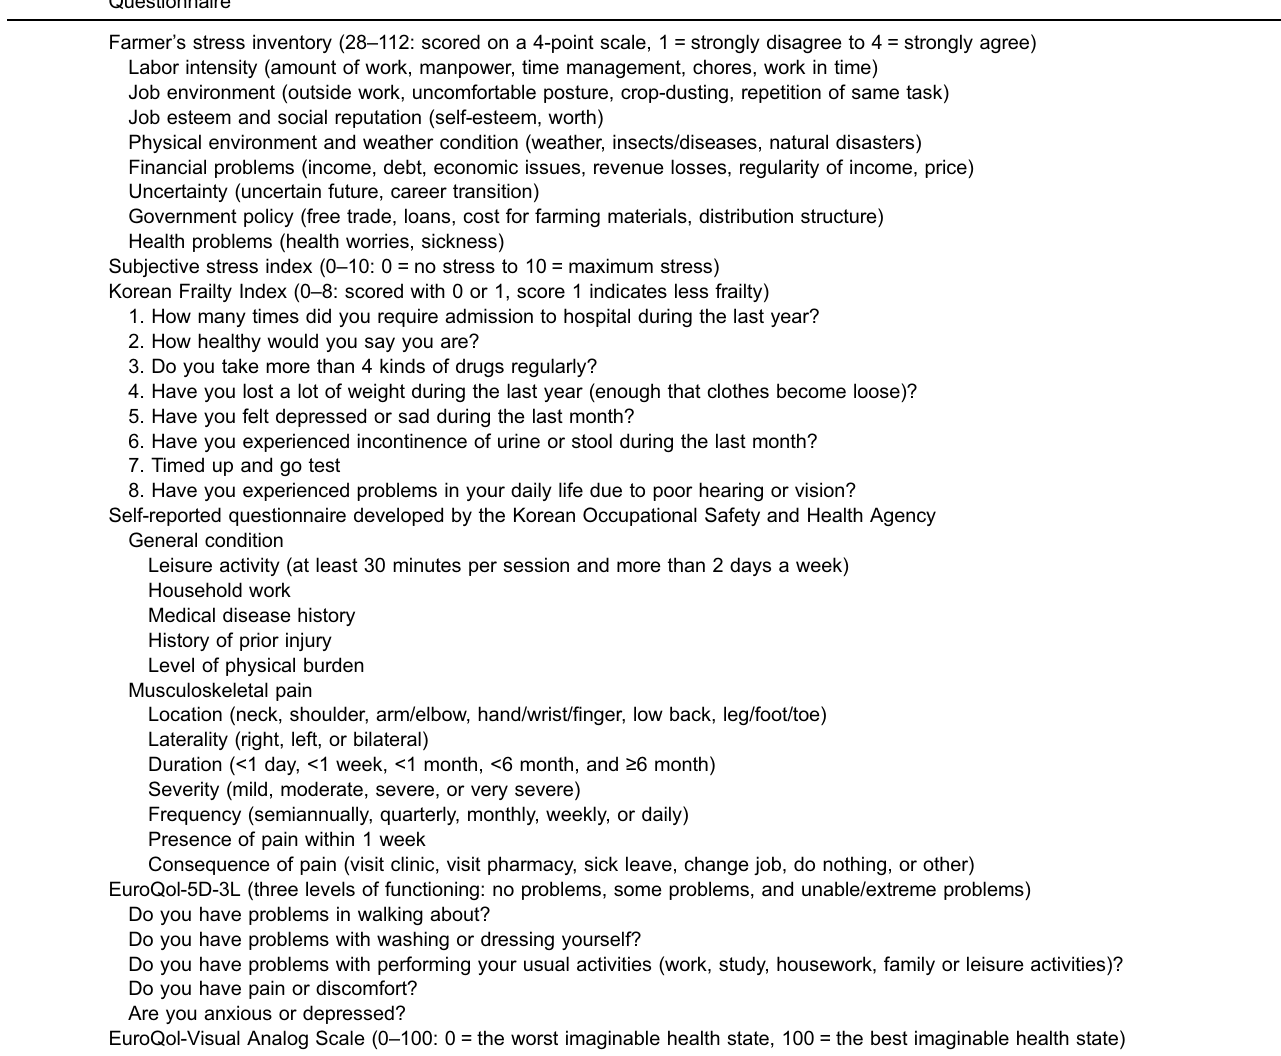
Table 1. Evaluated health characteristics